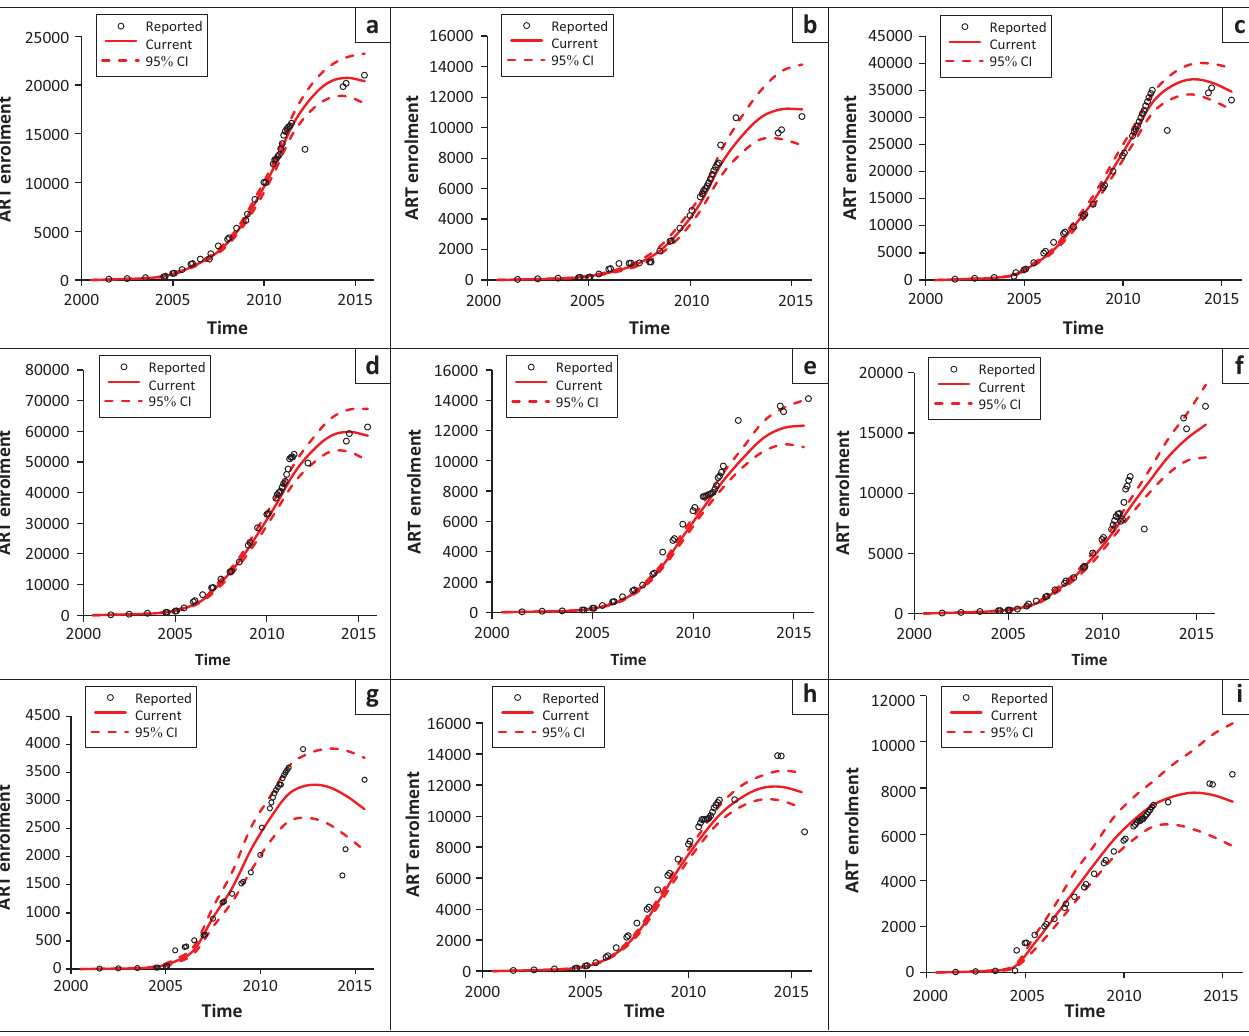
FIGURE 3: Posterior estimates of current antiretroviral treatment enrolment compared with reported antiretroviral treatment totals (children only): (a) Eastern Cape; (b) Free State; (c) Gauteng; (d) KwaZulu-Natal; (e) Limpopo; (f) Mpumalanga; (g) Northern Cape; (h) North West; (i) Western Cape.